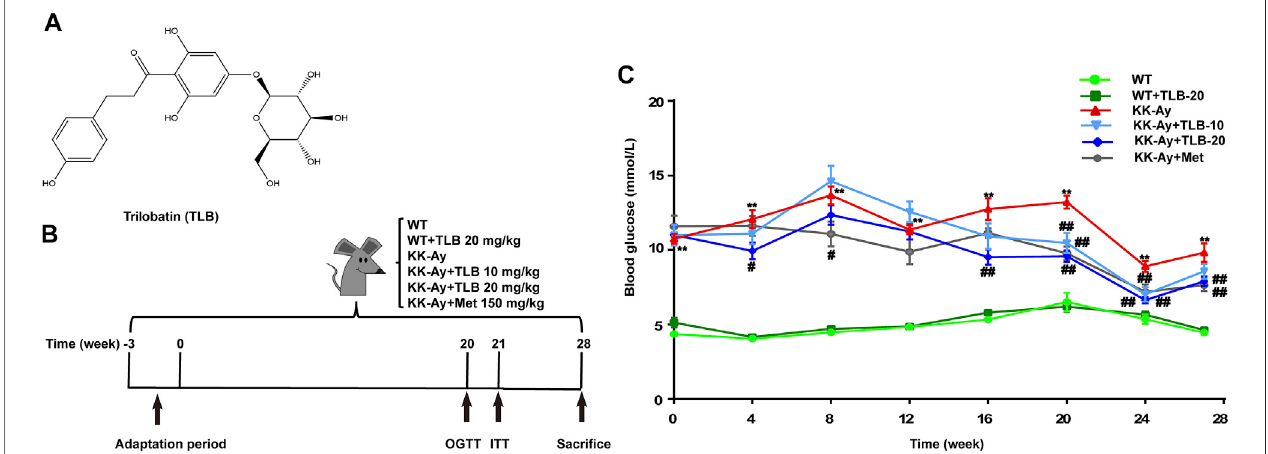
FIGURE1| TLBreducedhighbloodglucoselevelinKK-Aymice. (A) ChemicalstructureofTLB. (B) Schematicdiagramoftheexperimentalprotocols. (C) TheFBG curve of every group. **p < .01 vs. WT group; # p < .05 , ## p < .01 vs. KK-Ay group; n = 8 – 12 per group, mean ± SEM.